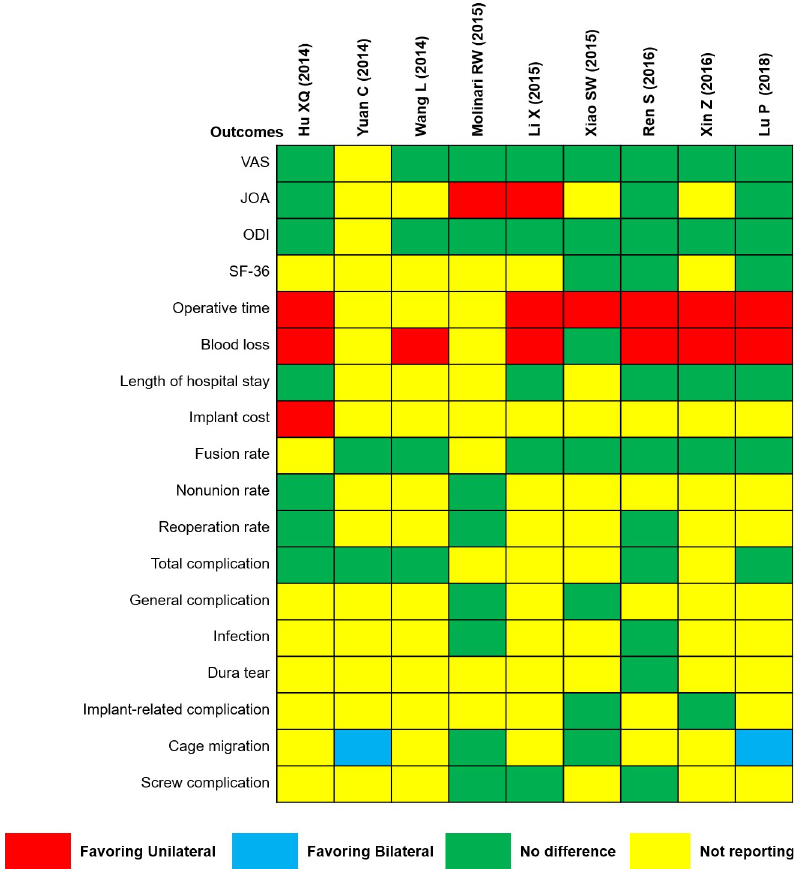
Fig 2. The pooled results of each included meta-analysis. VAS, Visual Analog Scale; JOA, Japanese Orthopedic Association; ODI, Oswestry Disability Index; SF-36, Short-Form Health Survey.